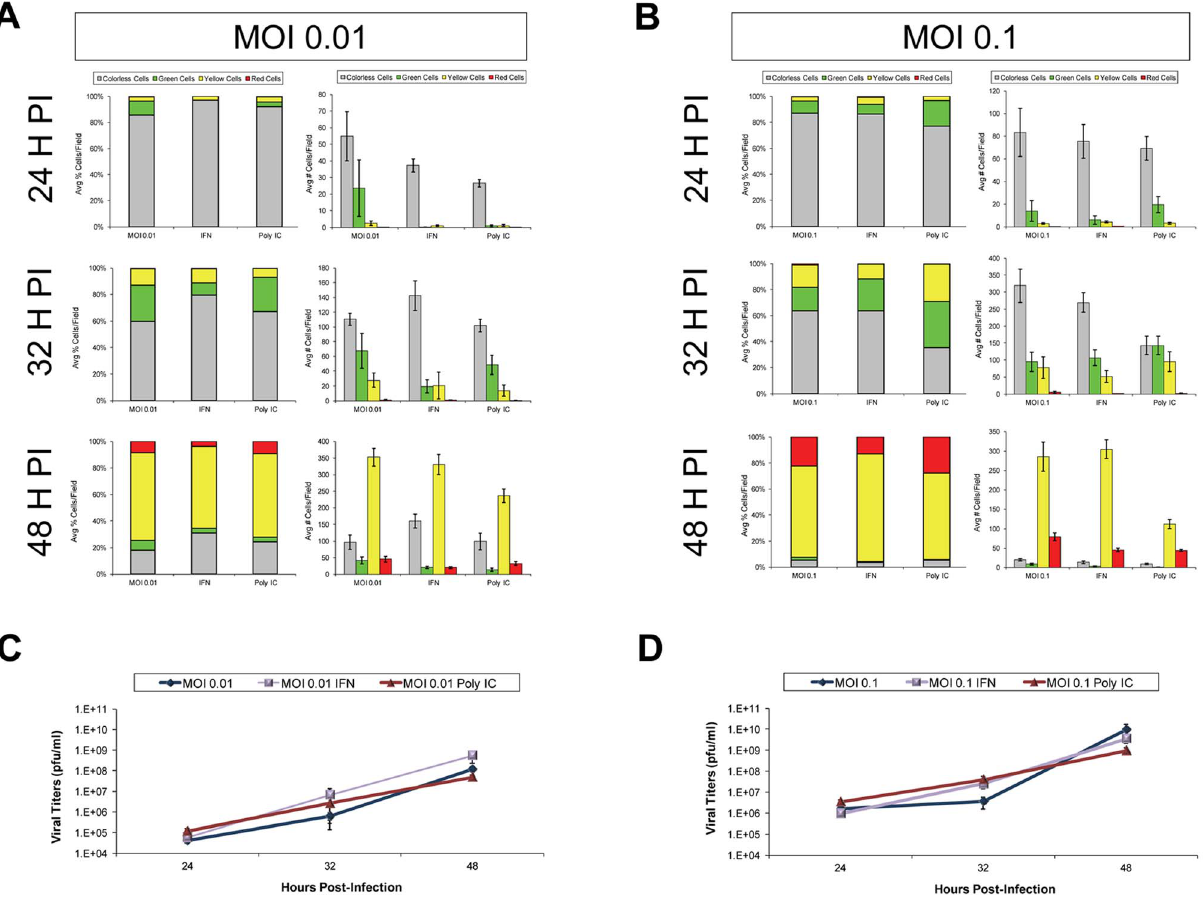
Figure 5. IFN- b or poly IC treatment restricted the progression of Timer-CVB3 infection in HeLa cells at low multiplicities of infection. (A) HeLa cells treated with IFN- b or Poly IC showed fewer signs of cytopathic effects and fewer green cells by fluorescence microscopy following infection with Timer-CVB3 as compared to untreated cultures at 24 hours PI. For HeLa cells given a relatively low amount of viral inoculum (moi=0.01), untreated cultures showed the highest percentage of green cells. By 32 hours PI, the number of cells exhibiting cytopathic effects was similar across the three conditions, and the percentage of cells expressing green ‘‘fluorescent timer’’ protein was similar between the untreated and the poly IC-treated cultures. In contrast IFN- b -treated HeLa cells continued to show reduced numbers of green cells. By 48 hours PI, the majority of the infected HeLa cells expressed both early and late viral proteins (yellow signal), and no significant differences were observed between the three conditions. (B) The effects of IFN- b and poly IC were minimized at higher moi. (C) , (D) Viral titers were similar between treatments at both the low and high moi.